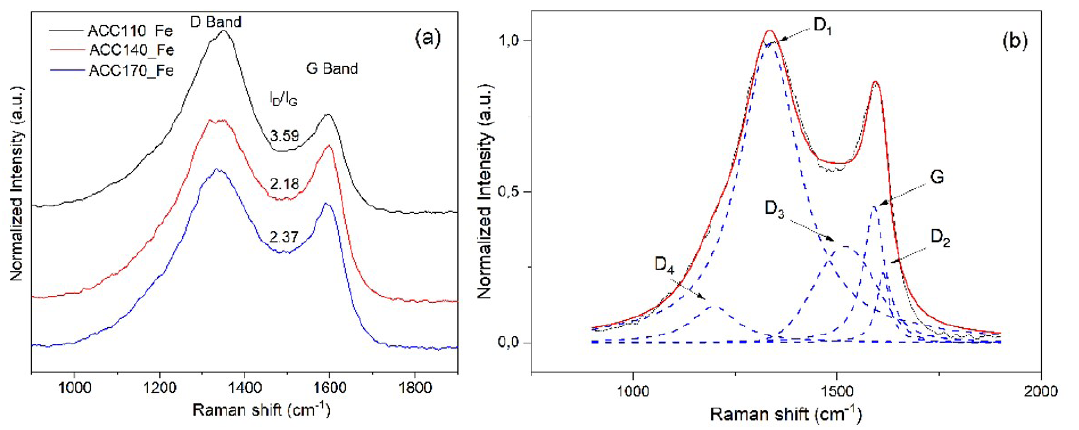
Figure 8. (a) Raman spectra of ACC110_Fe, ACC140_Fe, and ACC170_Fe samples and (b) adjustment of the Raman spectra of the sample ACC140_Fe.